Question: Provide a one-line summary of what is displayed.
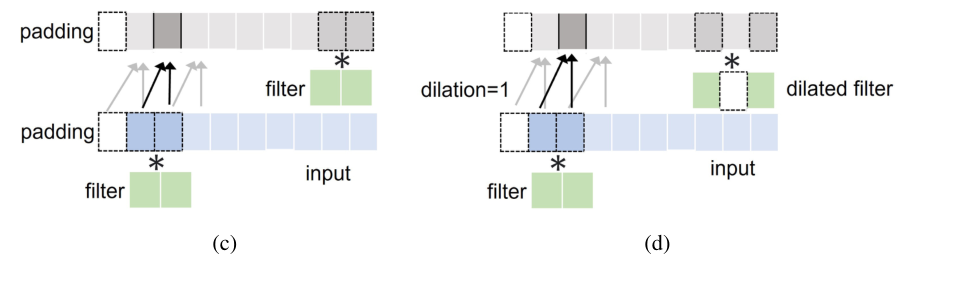
Answer: Illustration of different types of CNN convolutions for a 9-length time-series: (a) standard (vanilla) convolution process by a 3-length filter, (b) padded convolution, (c) casual convolution and (d) dilated- causal convolution by a 2-length filter.